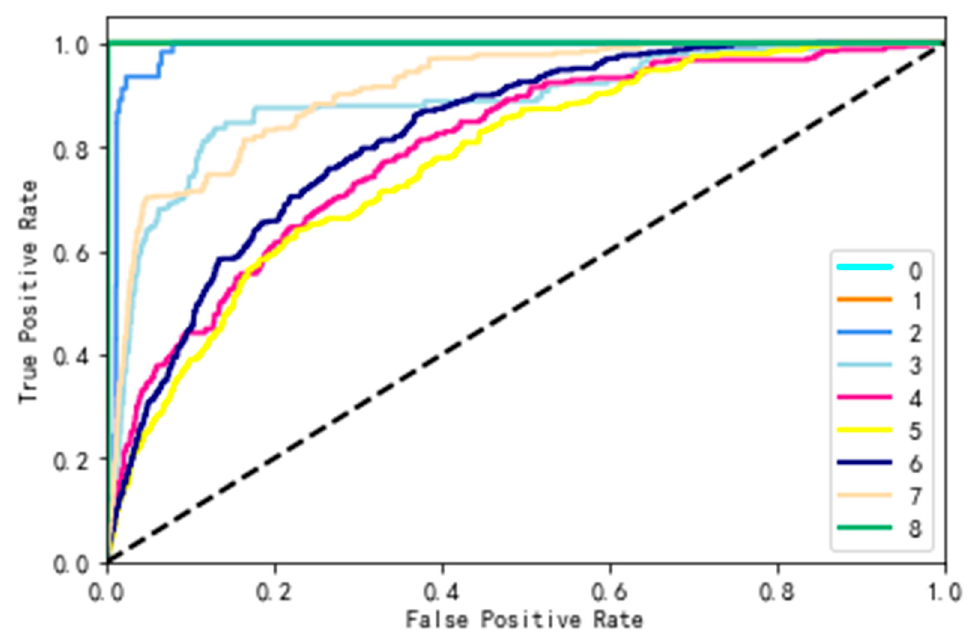
Figure 12. Wizarding_World_of_Harry_Potter receiver operating characteristic curve.